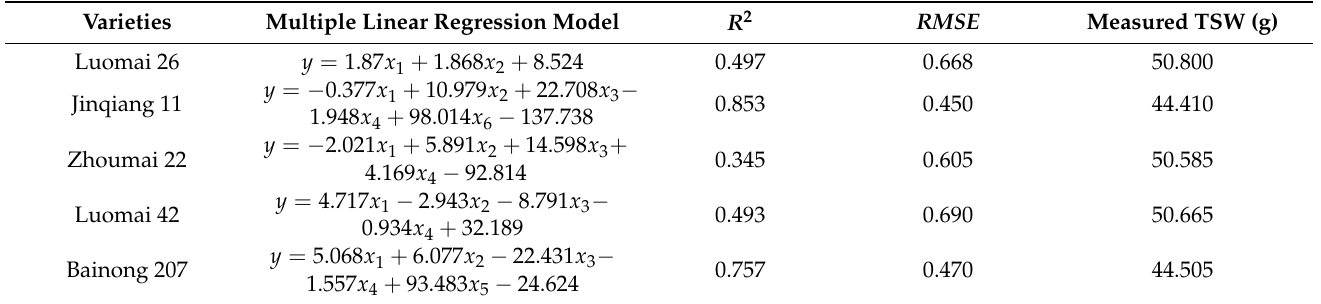
Table 3. Model for predicting thousand-grain weight of different varieties. Multiple Linear Regression